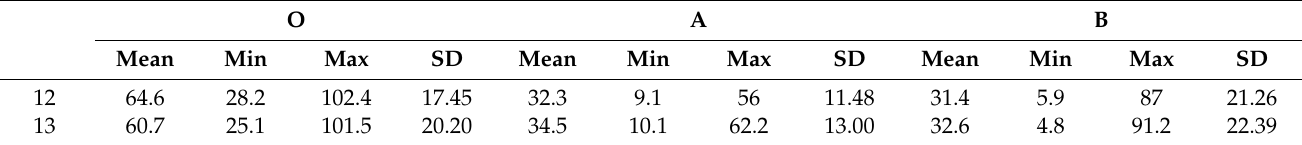
Table 12. Descriptive statistics of Tmrt at each test point on the 12th and 13th ( ◦ C).